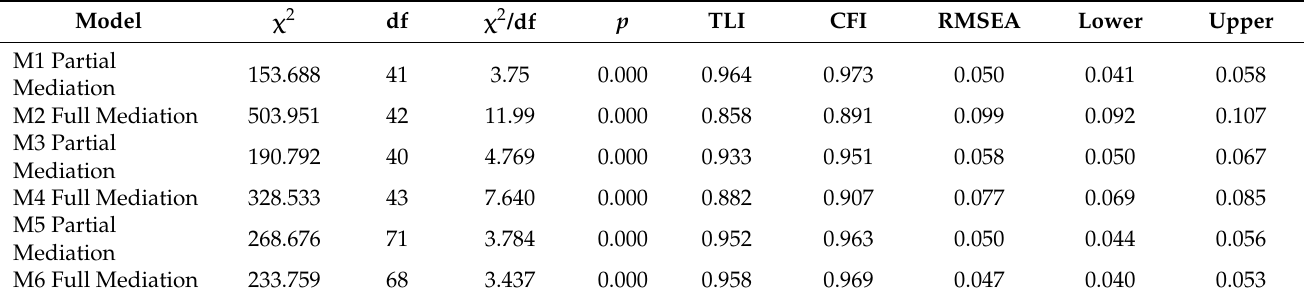
Table 3. Goodness of fit indexes for tested SEM Models.